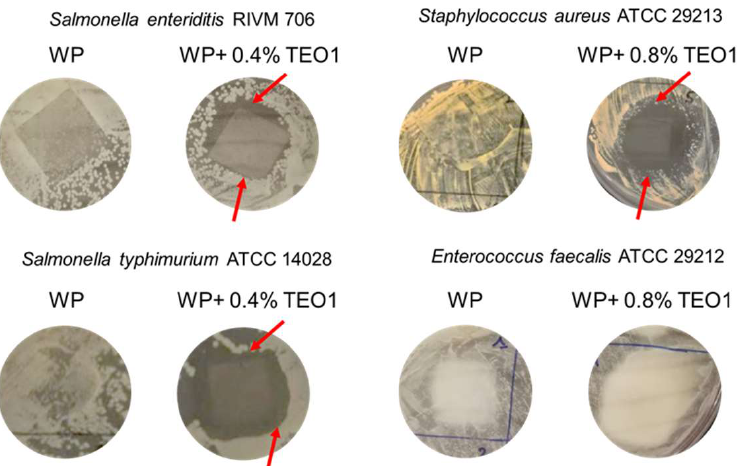
Figure 6. Antimicrobial effects of whey protein (WP)-based films, prepared either without or with Thymbra essential oil (TEO1). Antimicrobial effects were evaluated by analyzing the growth of the different bacterial cells held in direct contact with the films. The experiments were carried out in triplicate.